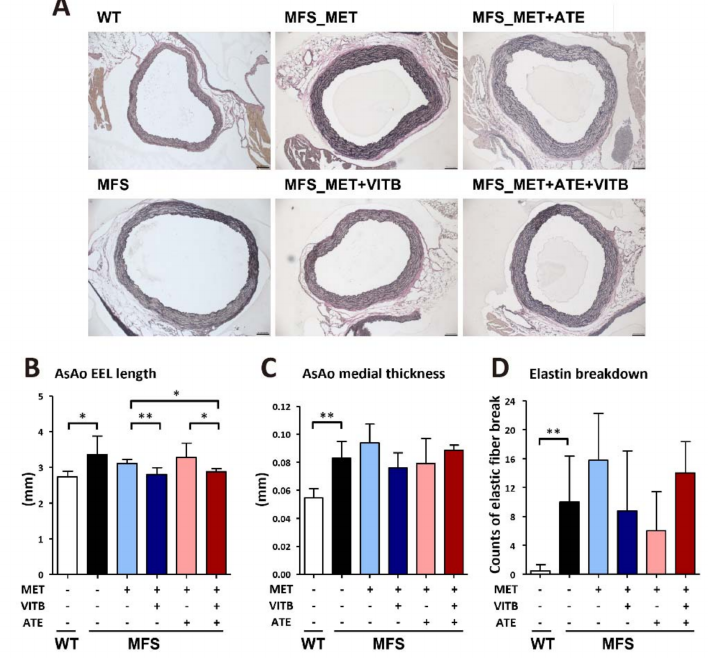
Figure 3. The effects of methionine and VITB treatment on thoracic aortic aneurysm in 6-month-old MFS mice. ( A ) Representative Verhoeff-Van Gieson stain section of MFS and WT ascending aorta (AsAo). Elastin was stained in black; collagen was stained in red. Scale bar, 100 µ m. ( B ) AsAo external elastic laminar (EEL) length in WT and MFS mice with different regiments ( n = 3 − 9 per group). ( C ) AsAo medial thickness in WT and MFS mice with different regiments ( n = 3–9 per group). ( D ) The counts of elastic fiber break in WT and MFS mice with different regiments ( n = 3–6 per group). Data are presented as the mean ± SD. * p < 0.05, ** p < 0.01.